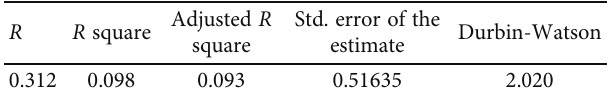
Table 6: Model summary.